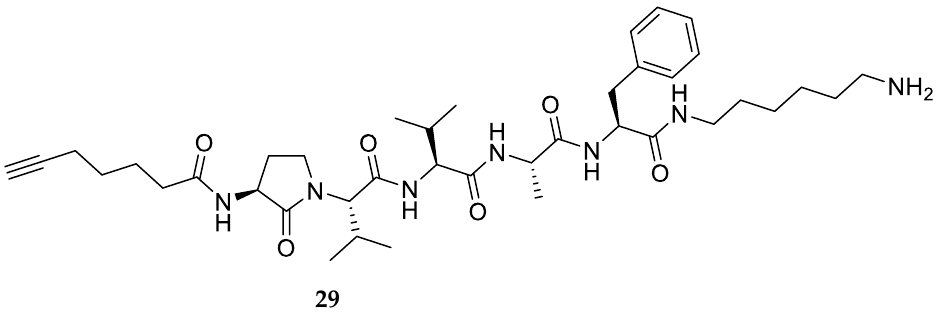
protocol described above for the synthesis of peptide 12 using Fmoc-Agl-Ala-OH (359 mg, 3 eq.) in the second coupling, followed by permethylation, peptide 28 (6.7 mg, 2%) was prepared and shown to be >95% pure by LC- MS analysis [50−90% MeOH (0.1% FA) in H 2 O (0.1% FA), 14 min, RT 9.01